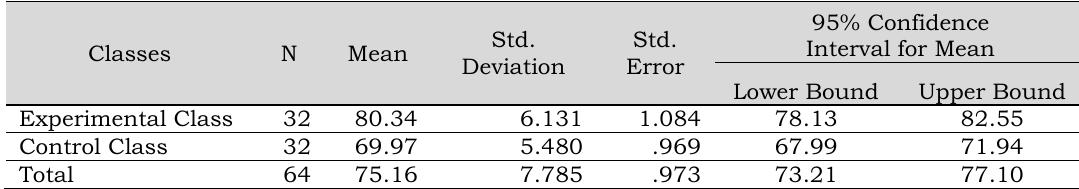
Table 3. The result of students’ writing scores